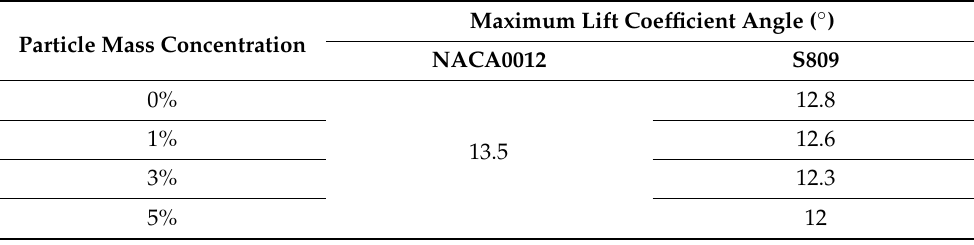
Table 5. Angles of attack, at which the maximum lift coefficient is obtained, for Case